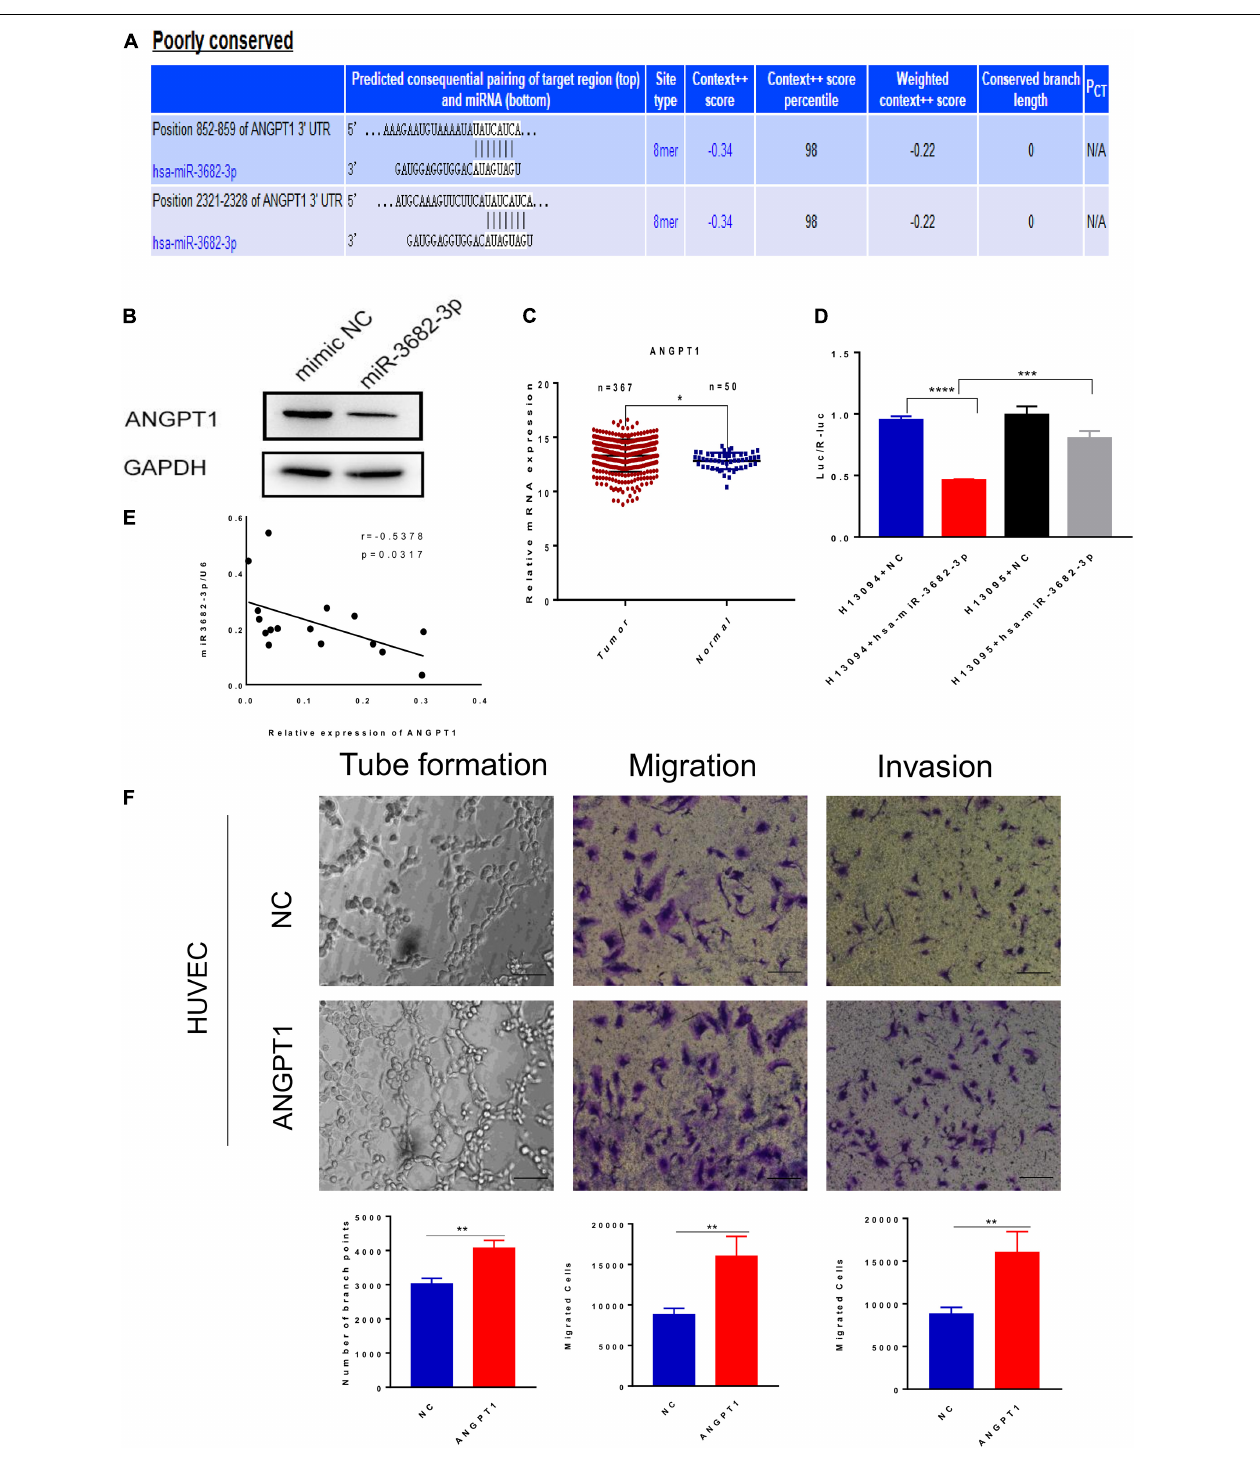
FIGURE 6 | Exosomal miR-3682-3p downregulated the expression of ANGPT1. (A) There were two potential binding sites for miR-3682-3p in the ANGPT1 transcript within its 3 (cid:48) –UTR (position 852-859 and 2321-2328). (B) The protein levels of ANGPT1 were determined by western blot. (C) ANGPT1 mRNA expression in hepatocellular carcinoma patients from the TCGA database. (D) miR–3682–3p significantly suppressed the luciferase activity of the ANGPT1–WT but had no obvious effects on the luciferase activity of ANGPT1-MUT. (E) Negative correlation between miR-3682-3p and ANGPT1 mRNA in 16 HCC tissues. (F) Tube formation assays, migration assays, and invasion assays of HUVECs transfected with ANGPT1-OE lentivirus or negative control. Scale bar, 200 µ m. (* p < 0.05; ** p < 0.01; *** p < 0.001; **** p < 0.0001).